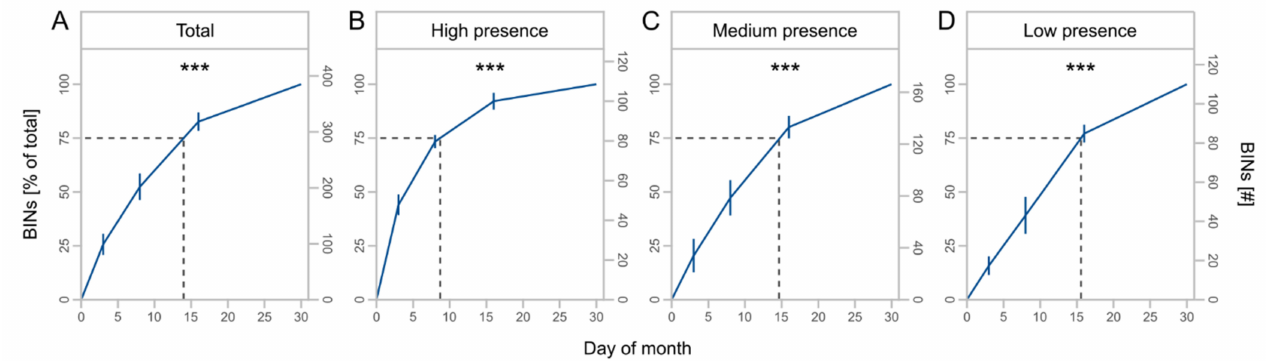
Figure 4. Mean cumulative proportion and number of BINs ± SD at different days of monthly trapping for total BINs ( A ) and presence subsets ( B – D ) with high (taxa caught at 4 sites), medium (taxa caught at 2 or 3 sites), and low presence (taxa caught at 1 site). Asterisks indicate significant effects of monthly trapping duration on number of BINs (significance code: *** p < 0.001). Dashed lines indicate the day of month at 75% of the total